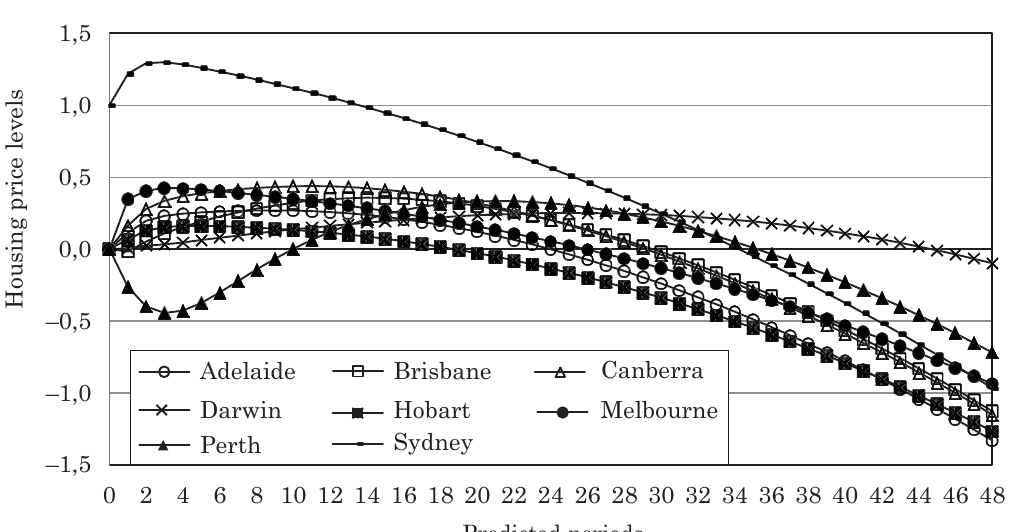
Figure 2. Predicted house price levels after a one-unit shock in Sydney house